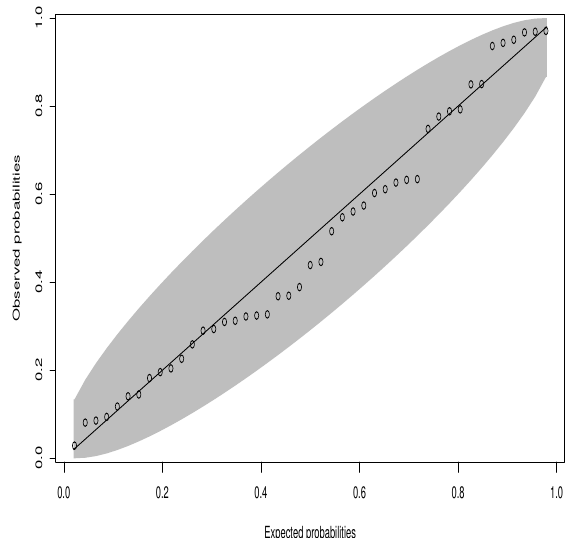
Figure 7. PP plot of the vinyl chloride data set.